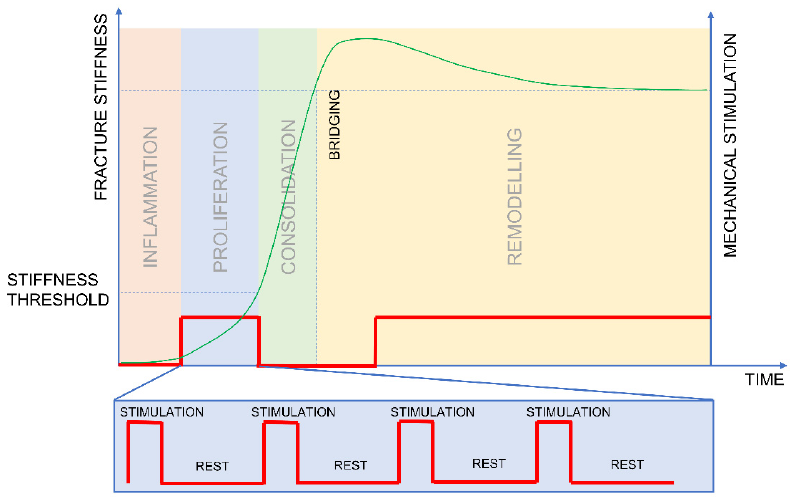
Figure 4. The protocol designed to test the hypothesis of the optimum delivery of mechanical stimulation.